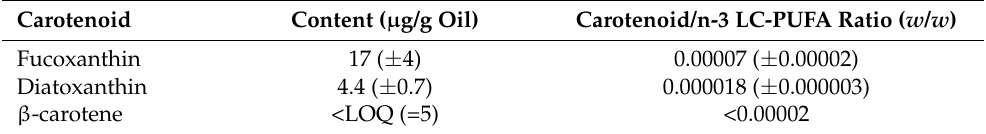
Table 2. Oil phase carotenoid content of the ‘Fish oil + Phaeodactylum biomass’ system.